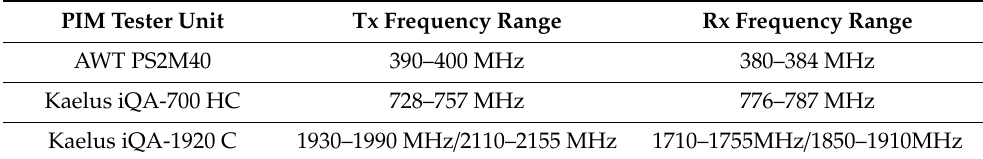
Table 5. The transmit and receive frequency range of the PIM